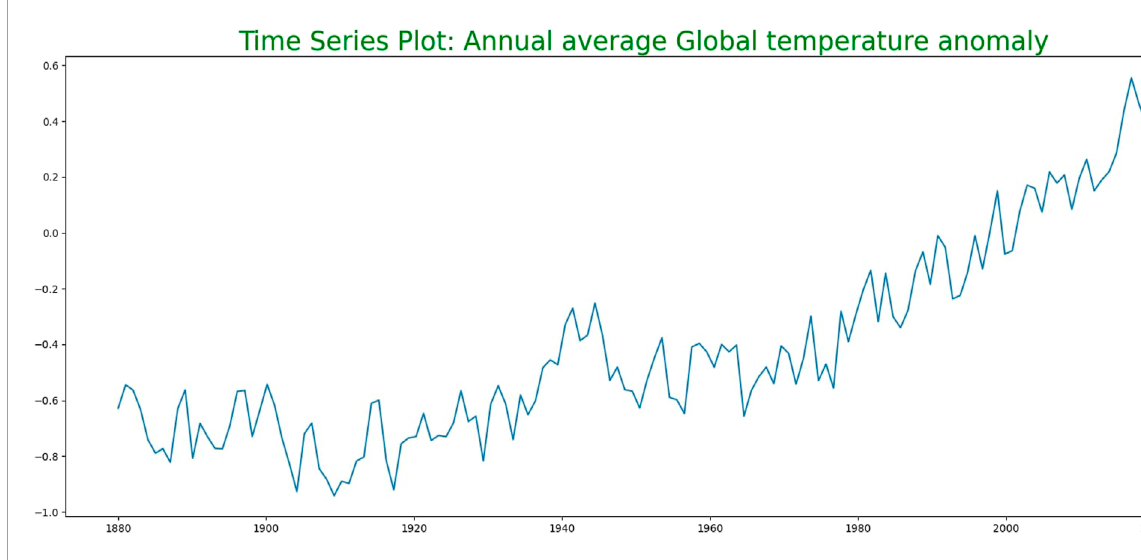
FIGURE 1 Time series of global temperature anomaly data.